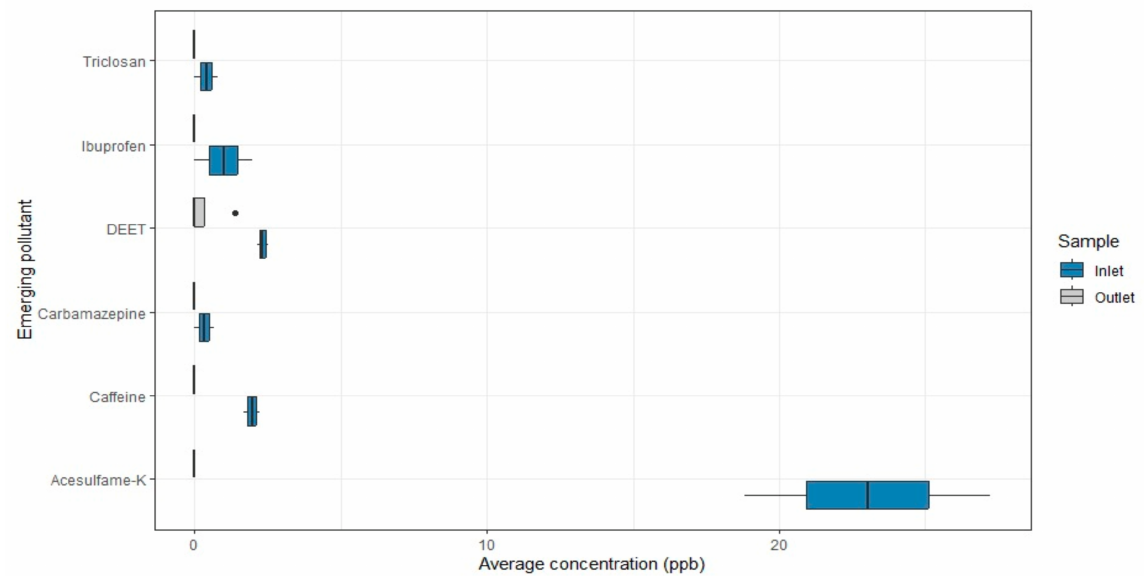
Figure 1. Emerging pollutants’ concentration in untreated and treated real wastewater.